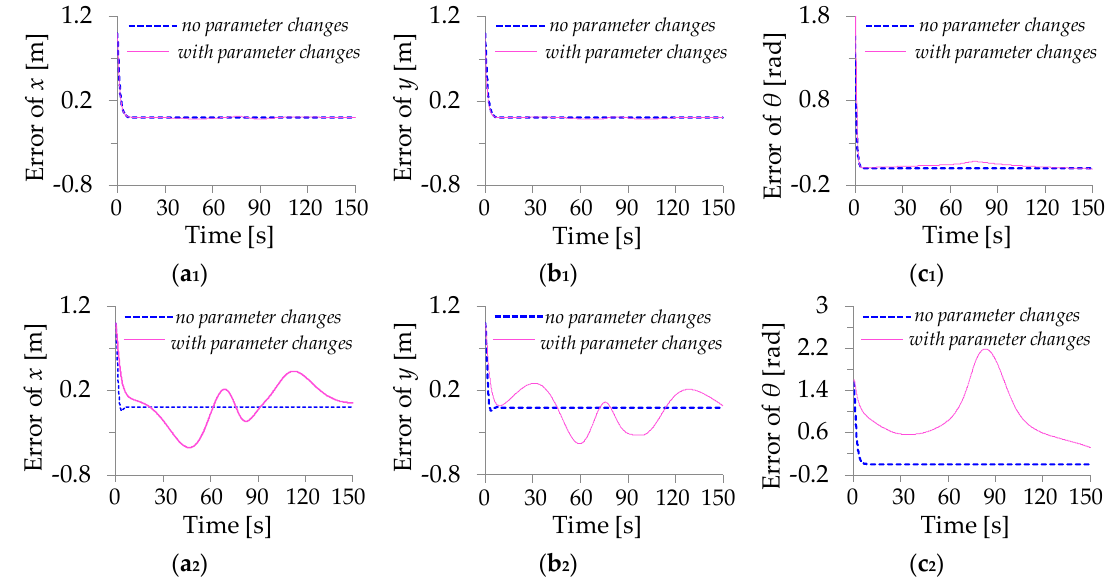
Figure 8. Trajectory tracking error for the rose curves (with robust compensation: ( a 1 ) x position; ( b 1 ) y position; and ( c 1 ) orientation θ ) (non-robust compensation: ( a 2 ) x position; ( b 2 ) y position ( c 2 ); and orientation θ ).